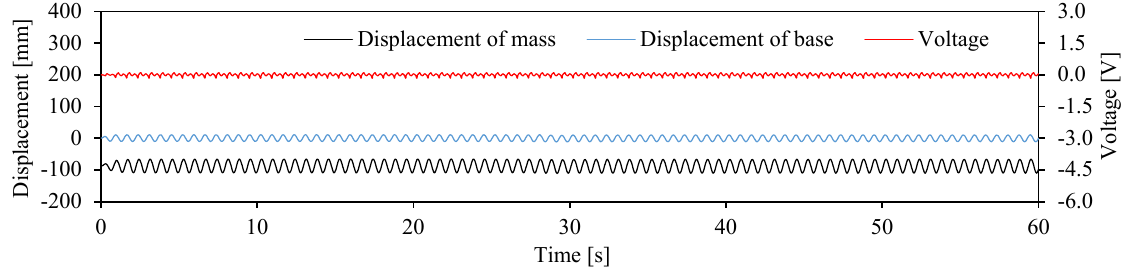
port point were 16.87 and 5.71 mm, respectively, which resulted in 1.28 mW of power